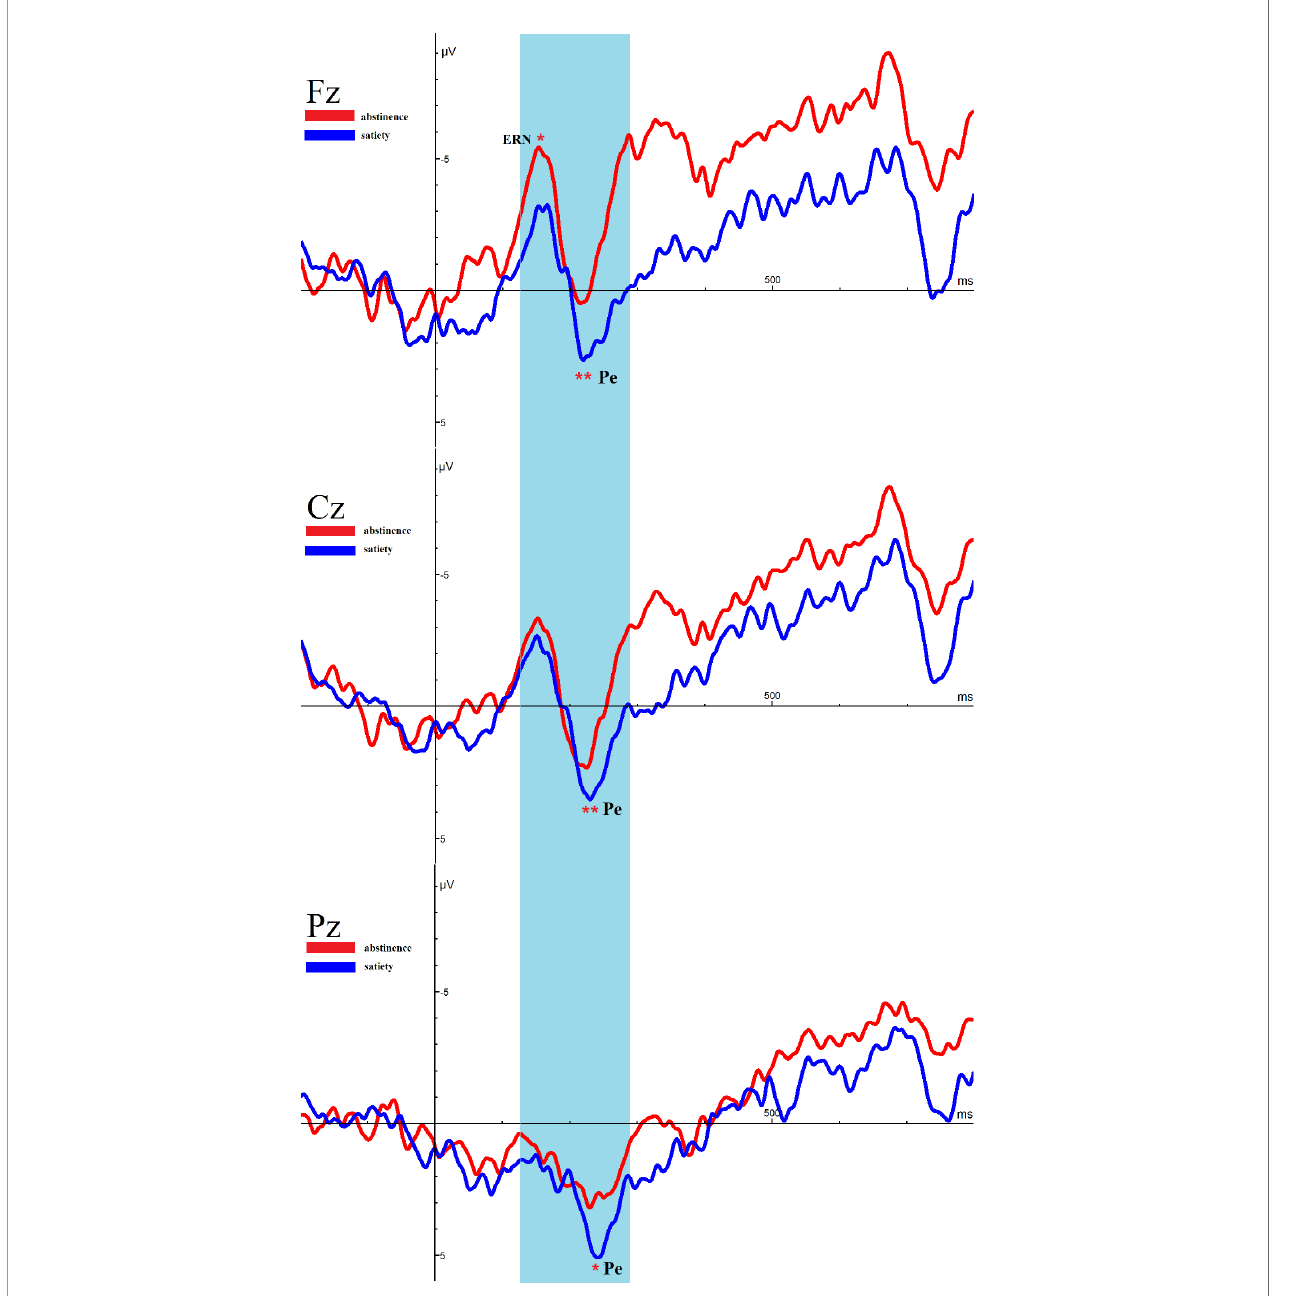
FIGURE 4 | Average event-related potential (ERP) activity during error trials of the Eriksen Flanker Task for satiety and abstinence. *p < 0.05, **p < 0.01. * and ** Represents an area where there are signi fi cant differences in ERP between satiety and abstinence in young